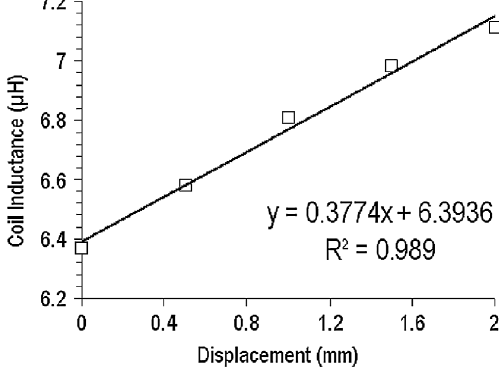
FIG. 4. Coil inductance measurement.